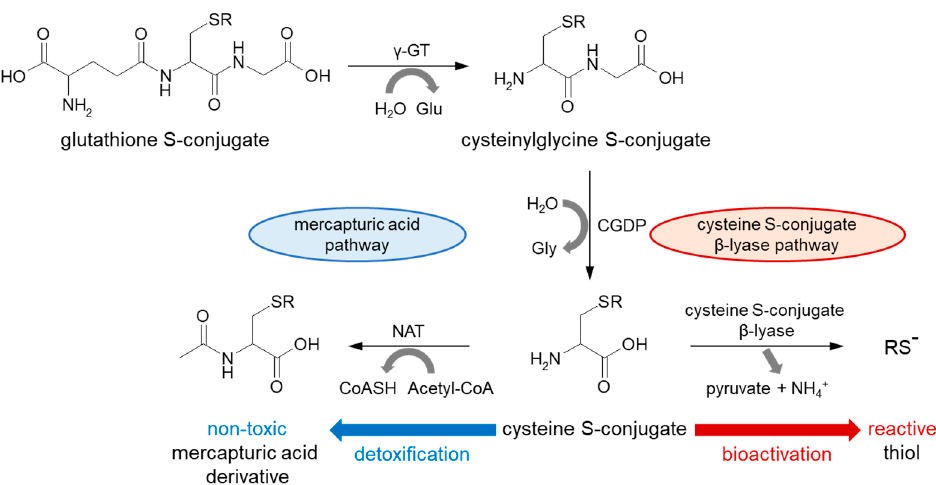
Figure 3. Metabolism of GSH conjugated product to mercapturic acid conjugated product in the mercapturic acid pathway and cysteine S-conjugate β -lyase-dependent bioactivation of cysteine S-conjugate. Acetyl-CoA = acetyl coenzyme A; CGDP = cysteinylglycine dipeptidase; CoASH = coenzyme A; Glu = glutamic acid; Gly = glycine; H 2 O = water; NAT = N-acetyltransferase; NH 4+ = ammonium ion; γ -GT = γ -glutamyl transferase.